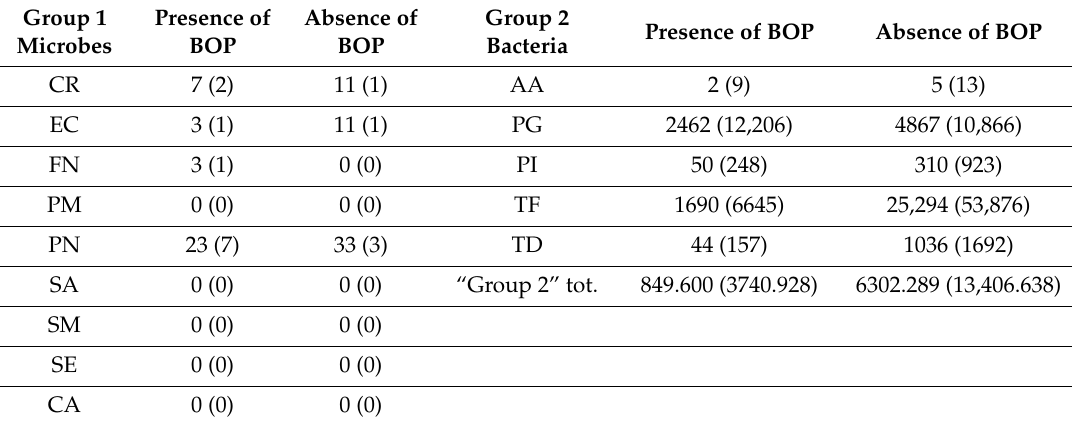
Table 4. Correlation between the microbial population and BOP in the CBP group. Percentage of positive cases (“Group 1” bacteria) and mean (SD) (“Group 2” bacteria) as evaluated in the 40 CBP